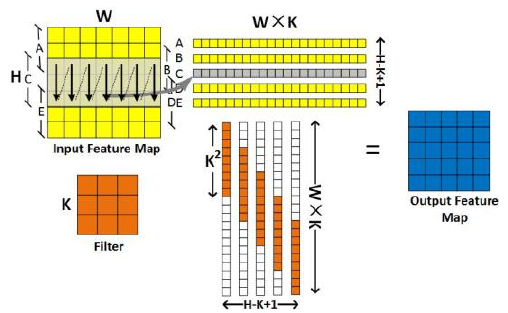
Figure 4. The operation process of MTCA.